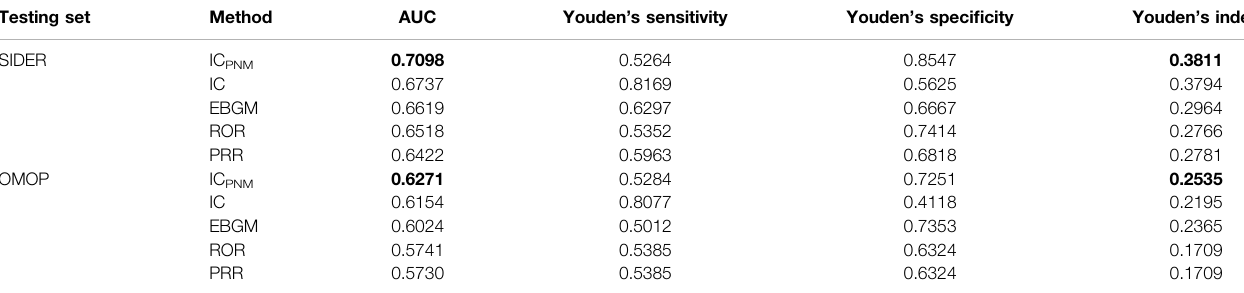
The bold values are to highlight the performance of the method, and have no speci fi c meaning.